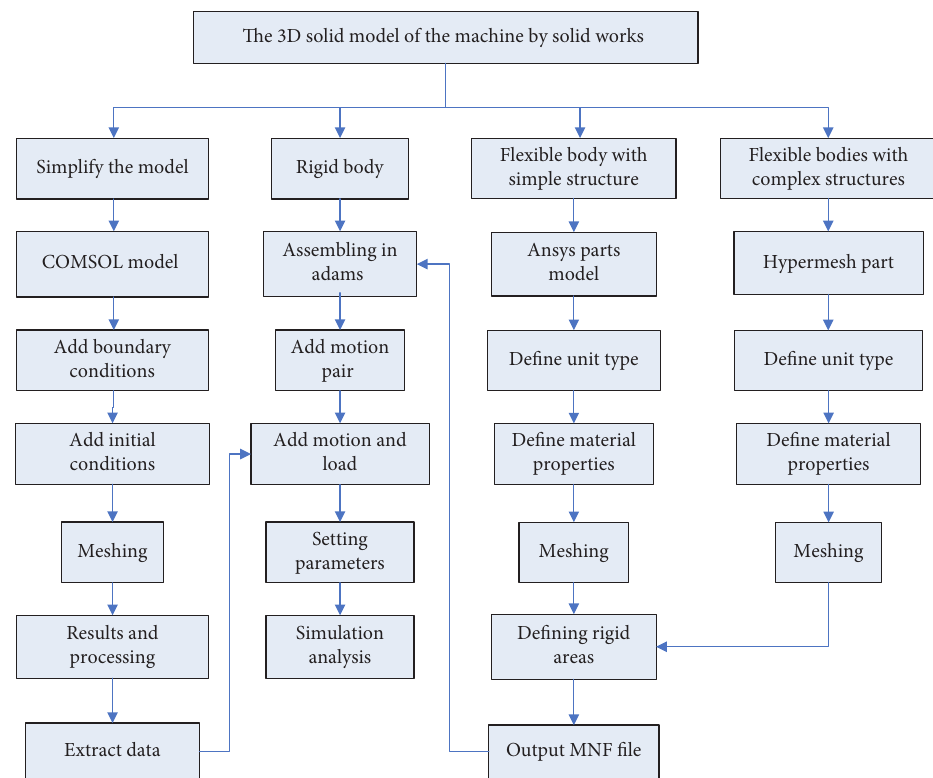
Figure 4: CAE cosimulation flow chart of liquid-solid rigid-flexible coupled multibody system.